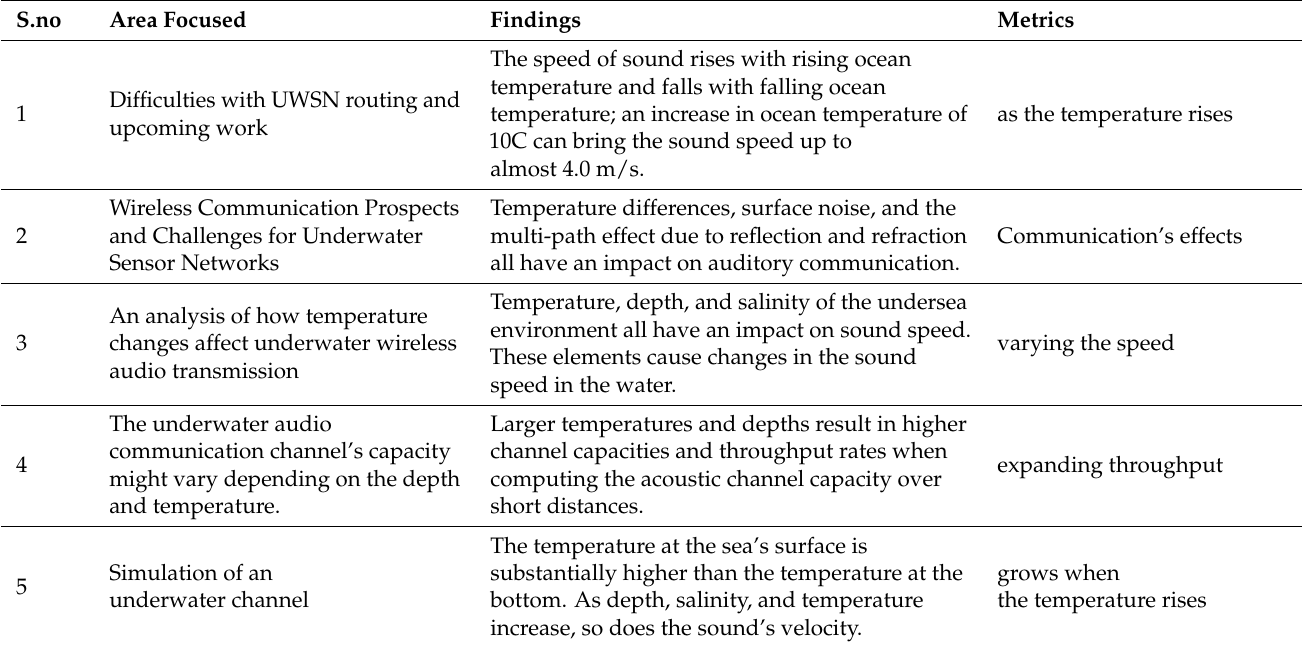
Table 4. Findings of propagation of